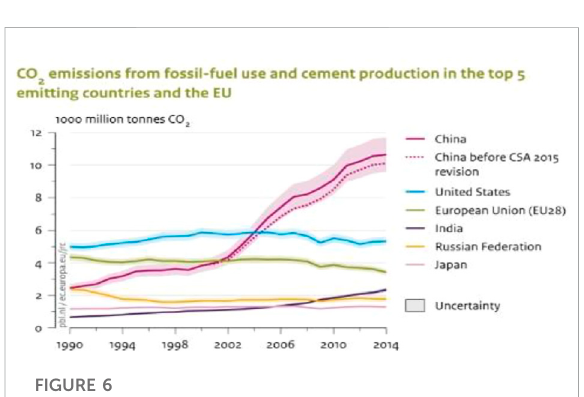
FIGURE 6 Top fi ve CO 2 emissions from fossil fuel-using